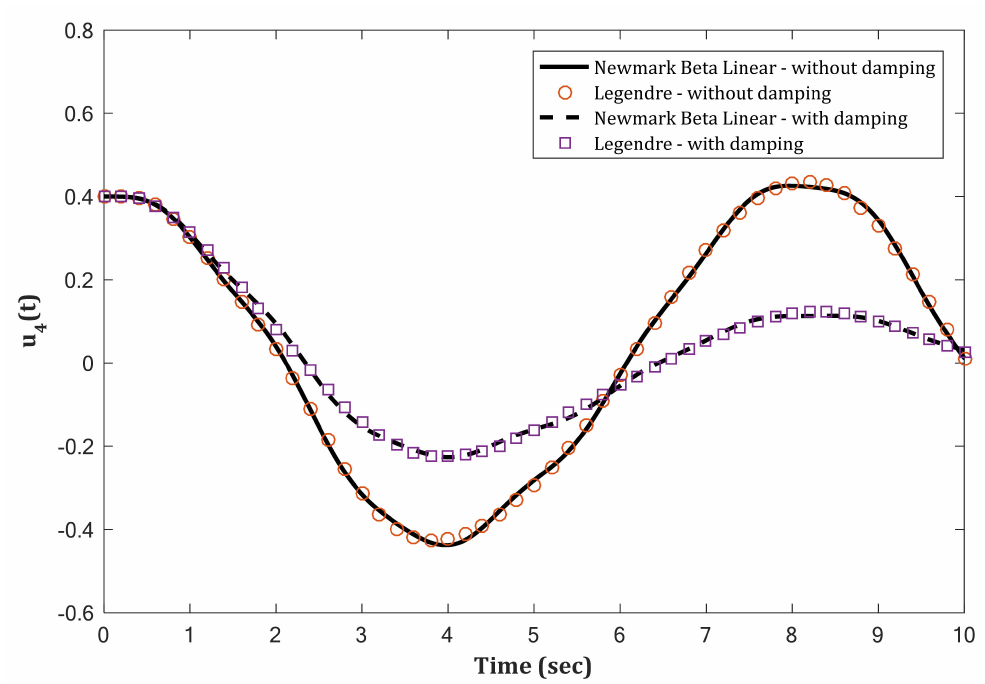
Figure 16. Free vibration analysis of a 5DOF system. Comparison of u 4 ( t ) as a function of time, as obtained using the LGM method or the linear Newmark- β